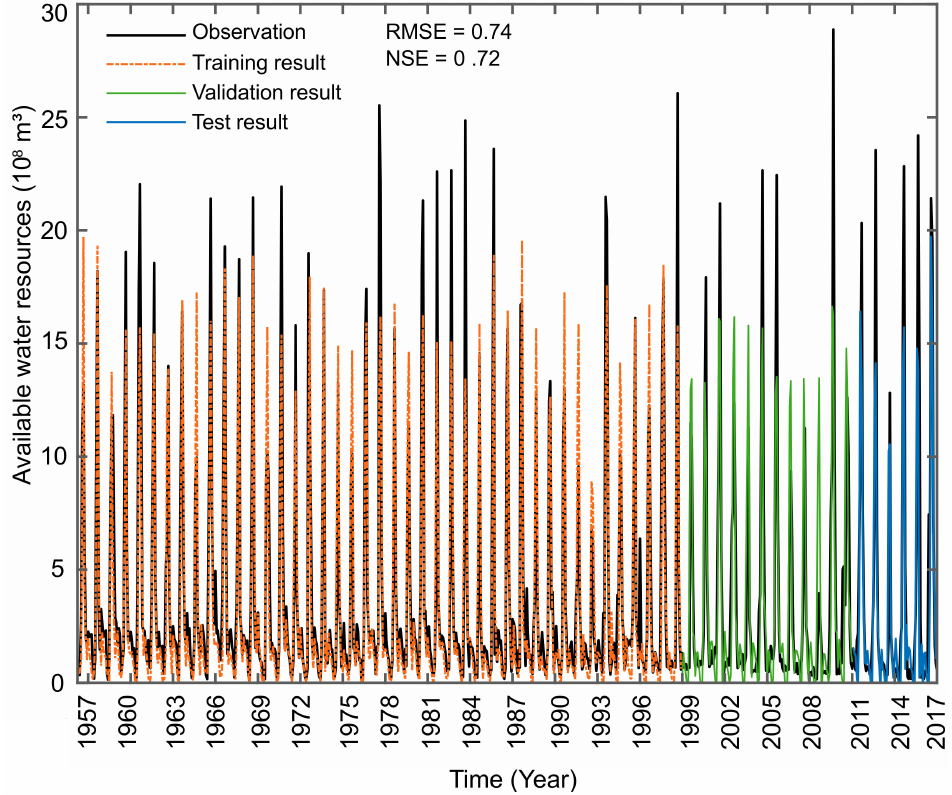
Figure 6. The comparison of the observed and simulated runoff at Alar station in the upper Tarim River Basin for the training, validation, and testing periods of the NARX network. The black indicates the observation, the orange indicates the training result, the green indicates the validation result, and the blue indicates the test